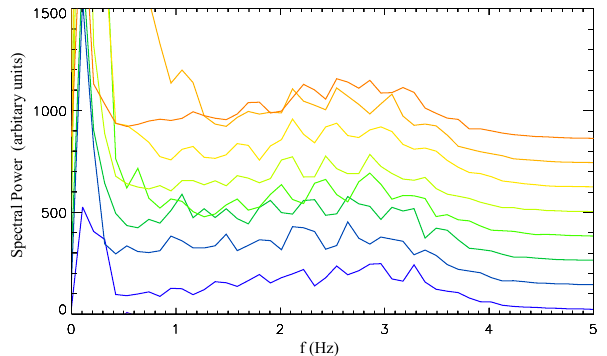
Figure 4. Stack plot of uncalibrated 20 minute-averaged power spectra for the Fig. 4. Stack plot of 20min-averaged power spectra for the east D component magnetic field on 04/10/98. The spectra are from 16.40-19 UT, going from blue-orange with time. west (D component) polarisation magnetic field on 4 October 1998 from pulsation magnetometer at Sodankyl¨a, Finland. The spectra are from 16:40–19:00 UT going from purple to orange with increas- ing time.